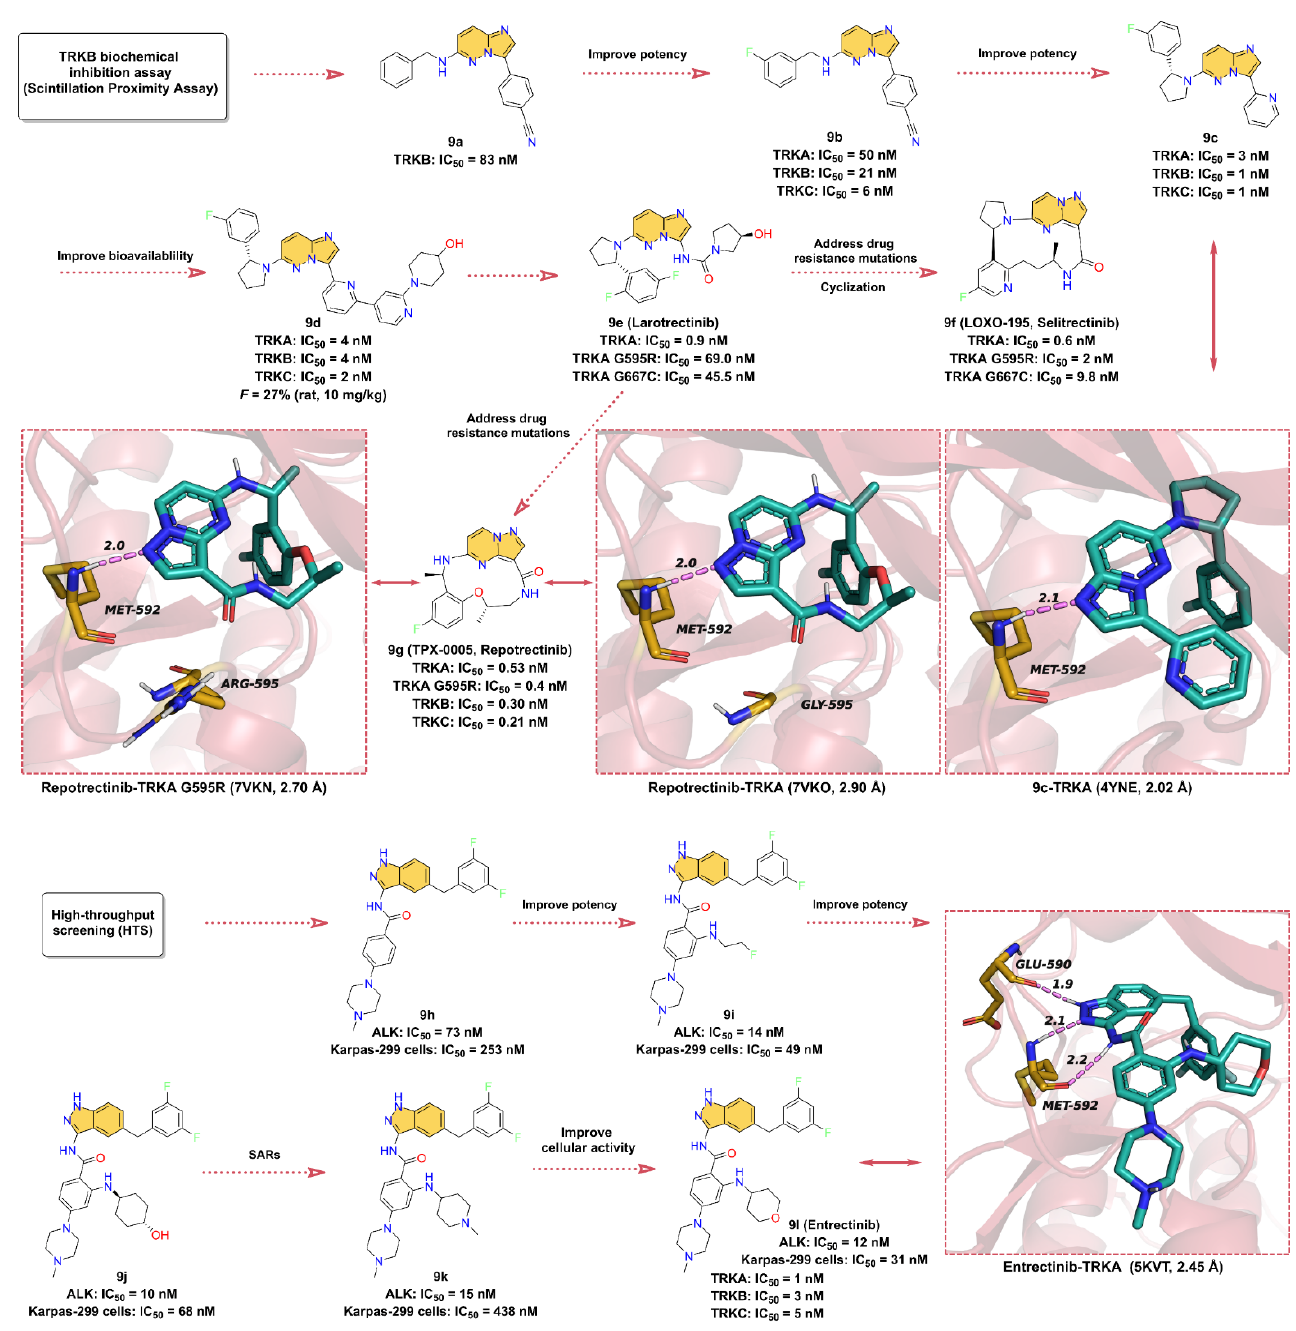
Figure 9. Key medicinal chemistry optimization of TRK inhibitors together with the binding models with TRK.